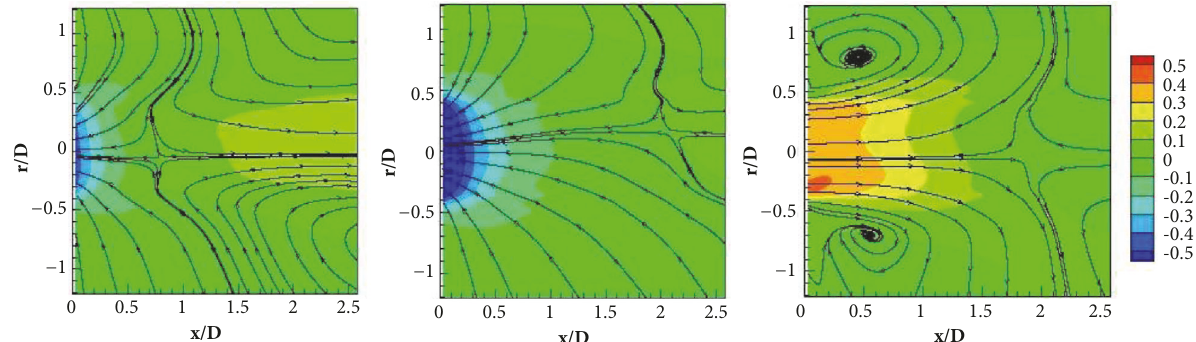
Figure 7: Two snapshots in the suction phase, for 𝑡 = 𝑇/18 (left plot) and 𝑡 = 2𝑇/9 (middle plot), and a snapshot at the very beginning of the injection phase, for 𝑡 = 𝑇/2 + 𝑇/72 (right